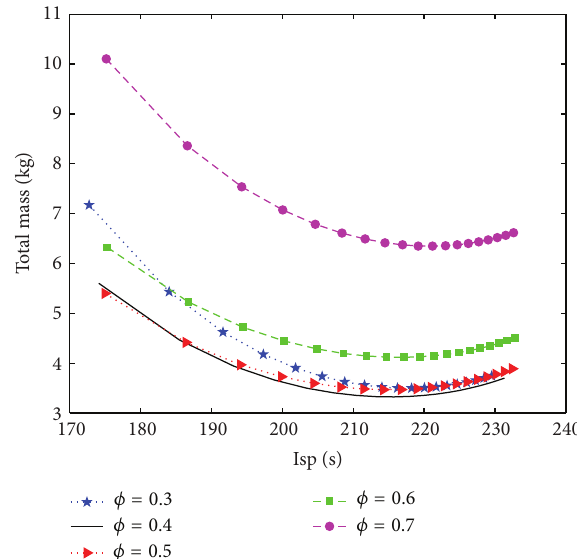
Figure 12: Movement of the minimum mass by variation of percent of NH 3 decomposition.